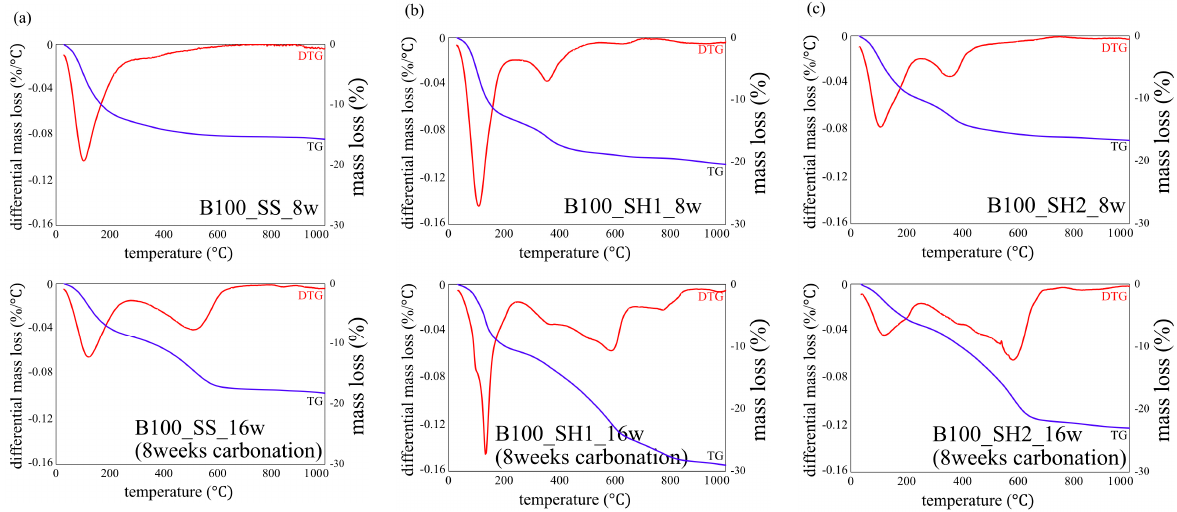
Figure 8. Thermogravimetric/differential thermal gravimetric (TG/DTG) analysis results for specimens of ( a ) B100_SS_8w and B100_SS_16w (8 weeks carbonation), ( b ) B100_SH1_8w and B100_SH1_16w (8 weeks carbonation), and ( c ) B100_SH2_8w and B100_SH2_16w (8 weeks carbonation).